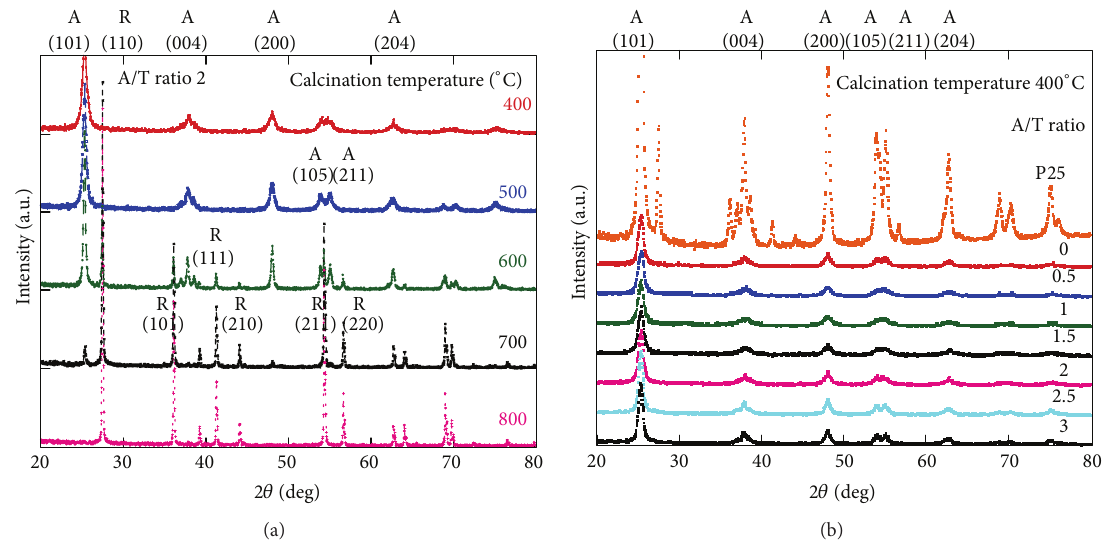
Figure 2: XRD patterns of N-TiO 2 samples prepared (a) at various calcination temperatures and (b) with various ammonia/TTIP ratios.